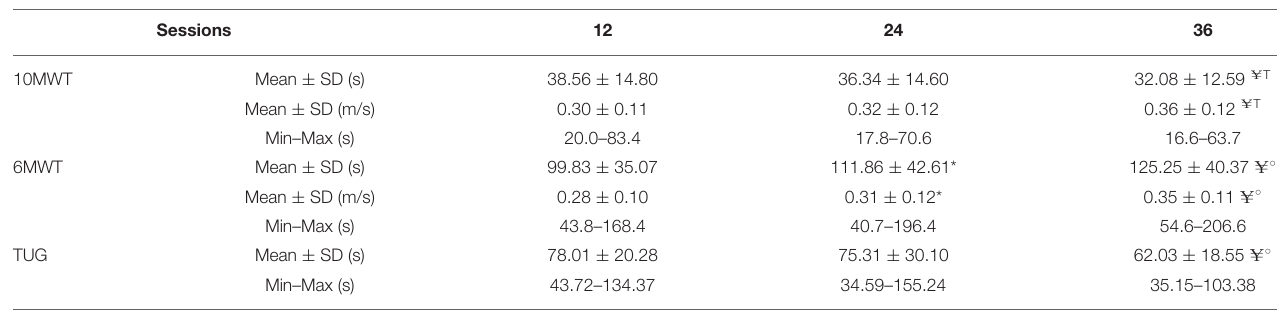
TABLE 6 | Walking test assessment